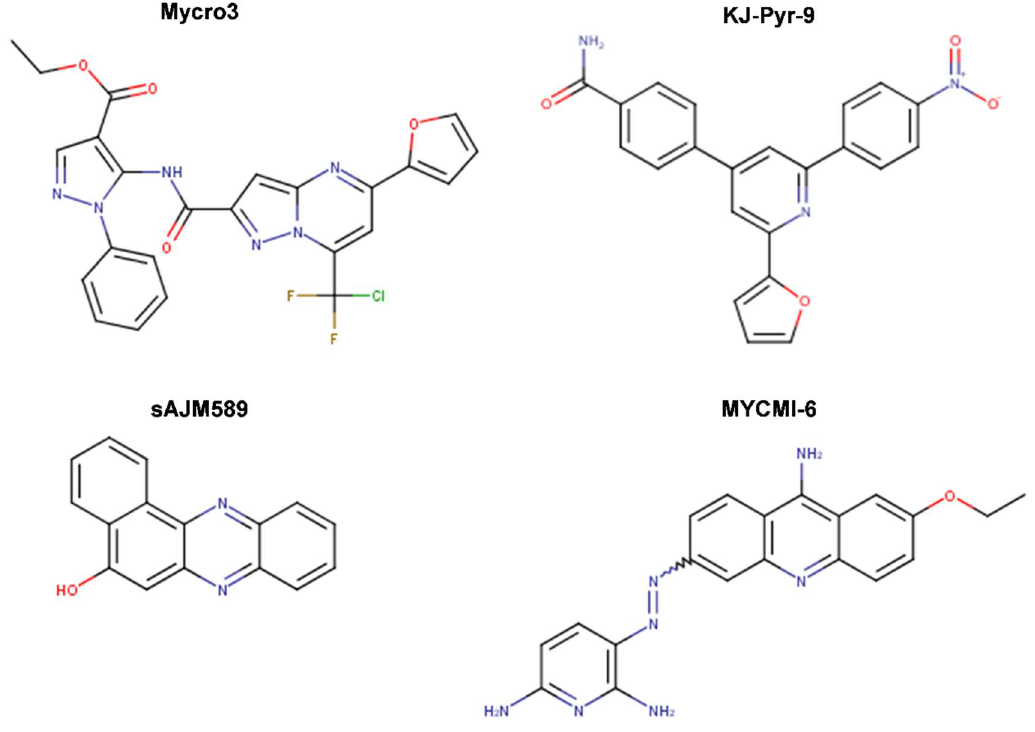
Figure 7. Chemical structures of Mycro3, KJ-Pyr-9, sAJM589, and MYCMI-6 inhibitors of Myc-Max dimerization identified through high-throughput screening of diverse small-sized compound libraries.